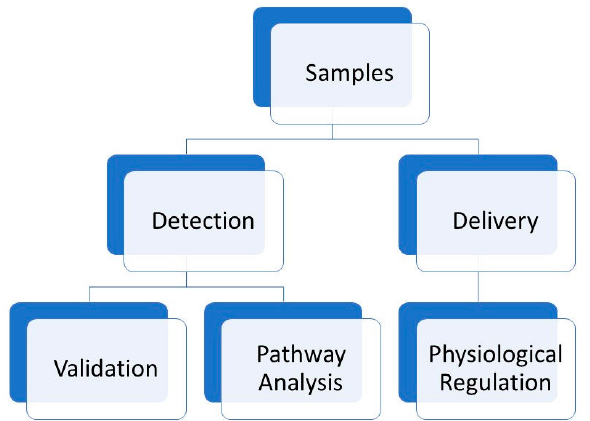
Figure 3. Summary of methodological workflow for studying miRNA function. The workflow sum- marizes the emerging high-throughput experimental approaches for the study of miRNA gene reg- ulatory networks.